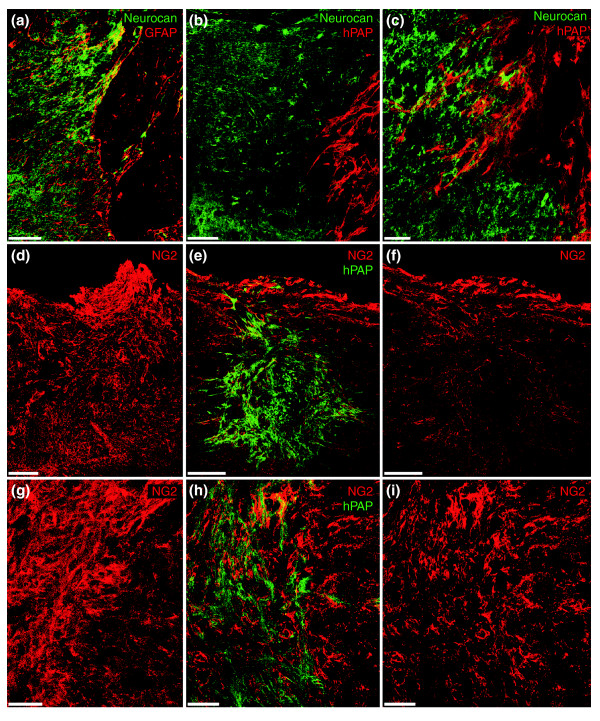
GDA transplantation suppresses neurocan and NG2 immunoreactivity. (a) At 4 days after injury, control lesion margins display dense neurocan immunoreactivity (green) mainly associated with fine, GFAP- processes and to a lesser extent with GFAP+ astrocyte cell bodies (red). (b) Neurocan immunoreactivity at 4 days after injury and transplantation is greatly reduced in margins of hPAP+ GDA-transplanted lesions. (c) At 8 days after injury and GDA transplantation, neurocan immunoreactivity within lesion margins has increased compared with the 4-day time point. Note, however, that intra-lesion hPAP+ GDAs continue not to be immunoreactive to neurocan. (d-f) GDA-transplanted lesion centers (e,f) at 4 days after injury show a marked reduction in NG2 immunoreactivity (red) compared with (d) control lesions. hPAP+ cells are stained green. (g-i) Although overall NG2 immunoreactivity has increased within the center of GDA-transplanted lesions (h,i) at 8 days after injury compared with (e,f) the 4-day time point, it is reduced compared with the more uniformly distributed NG2 immunoreactivity within the center of control lesions at 8 days after injury. Scale bars: (a,b,g) 100 μm; (c,h,i) 50 μm; (d-f) 200 μm.